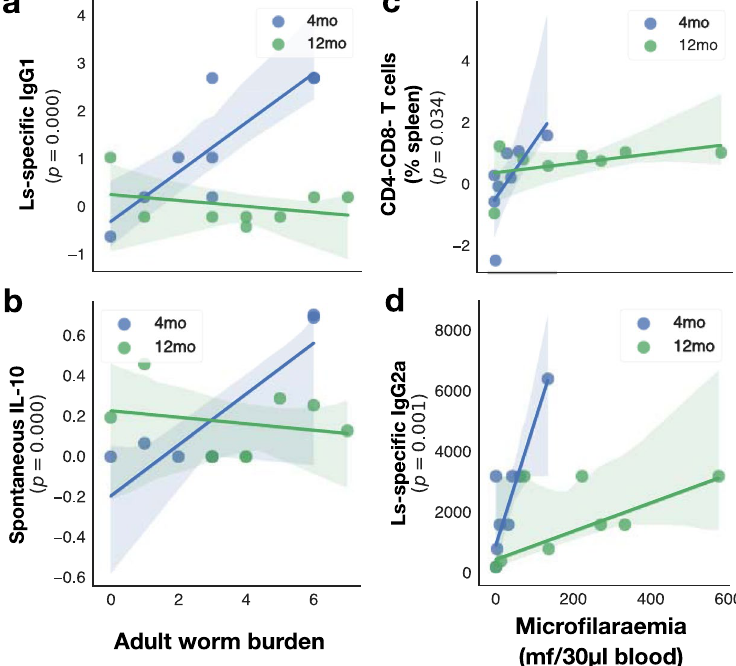
Figure 6. Age-dependent responses to adult worms and microfilariae. In 12mo mice, responses to increasing parasite burdens were weaker than in 4mo mice. Among the top features predicting adult worm burdens (see Fig. 3), ( a ) the concentration of parasite-specific IgG1 (P AGExNW < 0.0001, GLM, n = 8 per group) and ( b ) the spontaneous production of IL-10 (P AGExNW ≤ 0.0001, GLM, n = 8 per group) were the only features significantly affected by host age. Of the top features predicting circulating microfilariae densities (see Fig. 4), only ( c ) CD4-CD8- double negative T cells (P AGE = 0.034, GLM, n = 8 per group) and ( d ) parasite-specific IgG2a (P AGExMF = 0.001, GLM, n = 8 per group) were affected by host age. Each point represents a mouse, the solid line is the robust regression and the shaded areas represent the corresponding 95% bootstrapped confidence